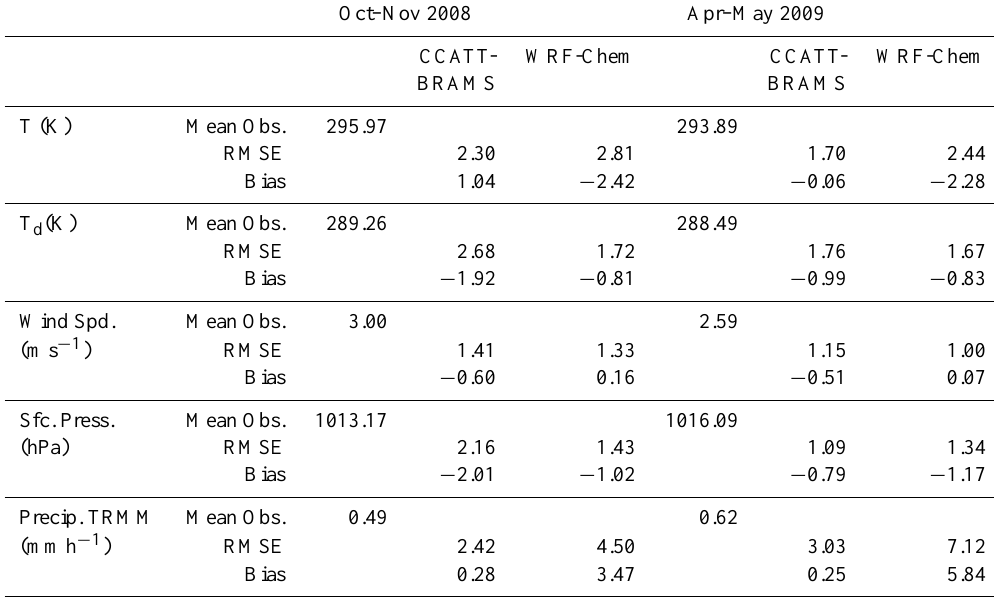
Table 3. Values of RMSE and bias for CCATT-BRAMS and WRF-Chem simulations for 26 METAR and 52 SYNOP stations in the